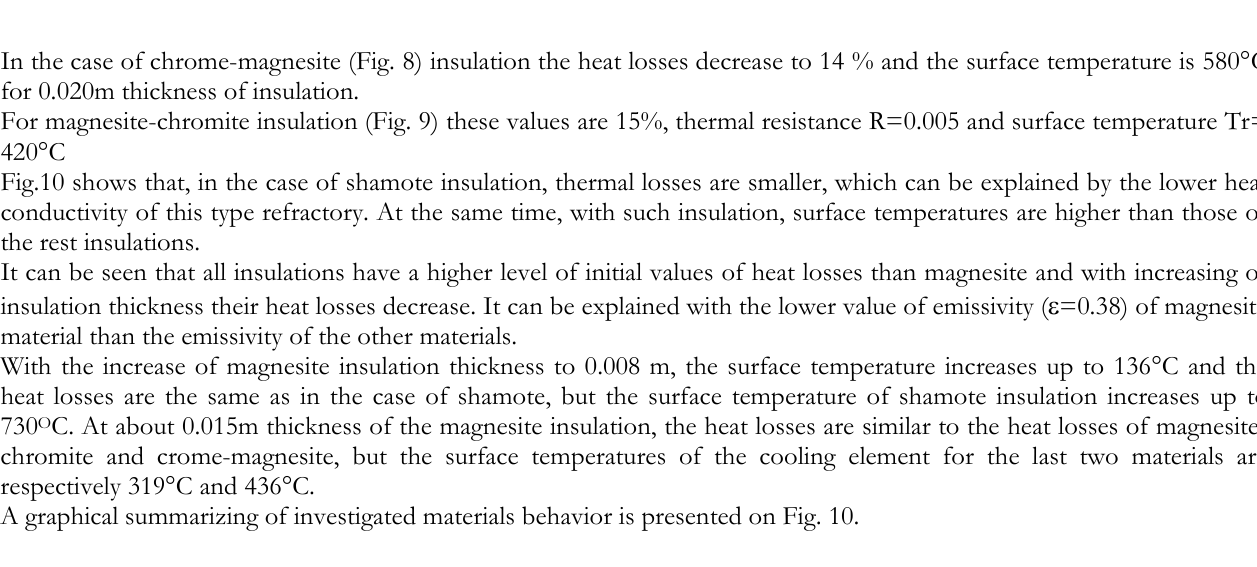
Figure 6: Heat losses, surfaces temperature and thermal resistance of insulation as a function of magnesite insulation thickness